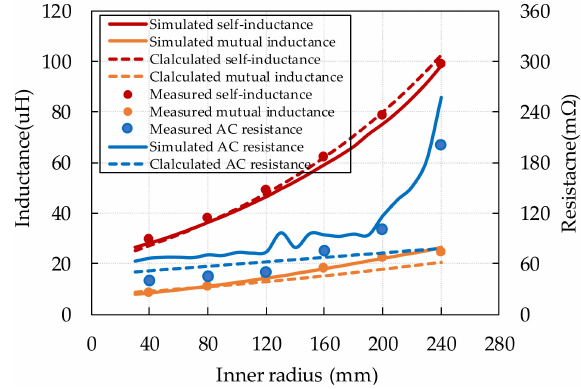
Figure 16. Relationship between coil inner radius and coil system parameters with fixed coil turns and outer